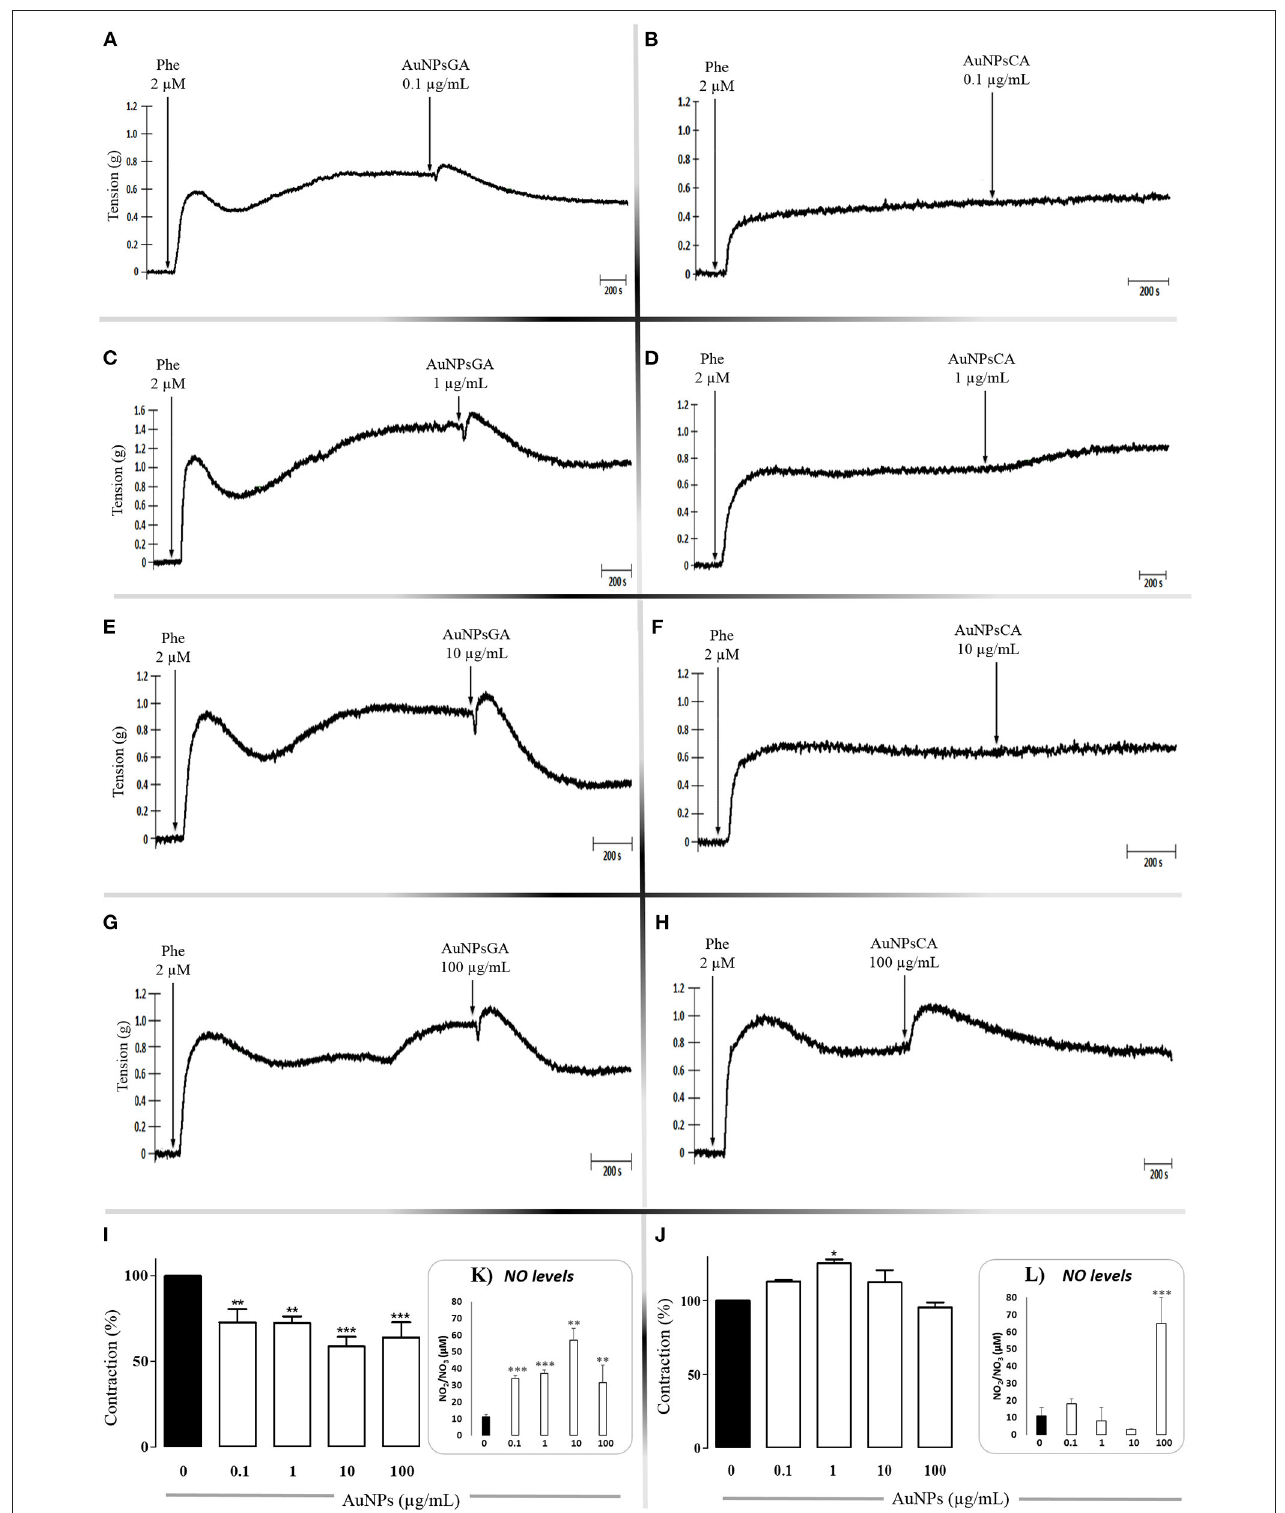
FIGURE 3 | Effects induced by singles concentrations of AuNPsGA and AuNPsCA. Effects induced by single concentrations of AuNPsGA (A) 0.1, (C) 1, (E) 10 and (G) 100 µ g/mL; and AuNPsCA (B) 0.1, (D) 1, (F) 10, (H) 100 µ g/mL on pre-contracted aortic rings with Phe 2 µ M. Results are representative of three independent experiments. Percentage of contraction induced by AuNPsGA (0.1, 1, 10, and 100 µ g/mL) (I) AuNPs-CA (0.1, 1, 10, and 100 µ g/mL) (J) on pre-contracted aortic